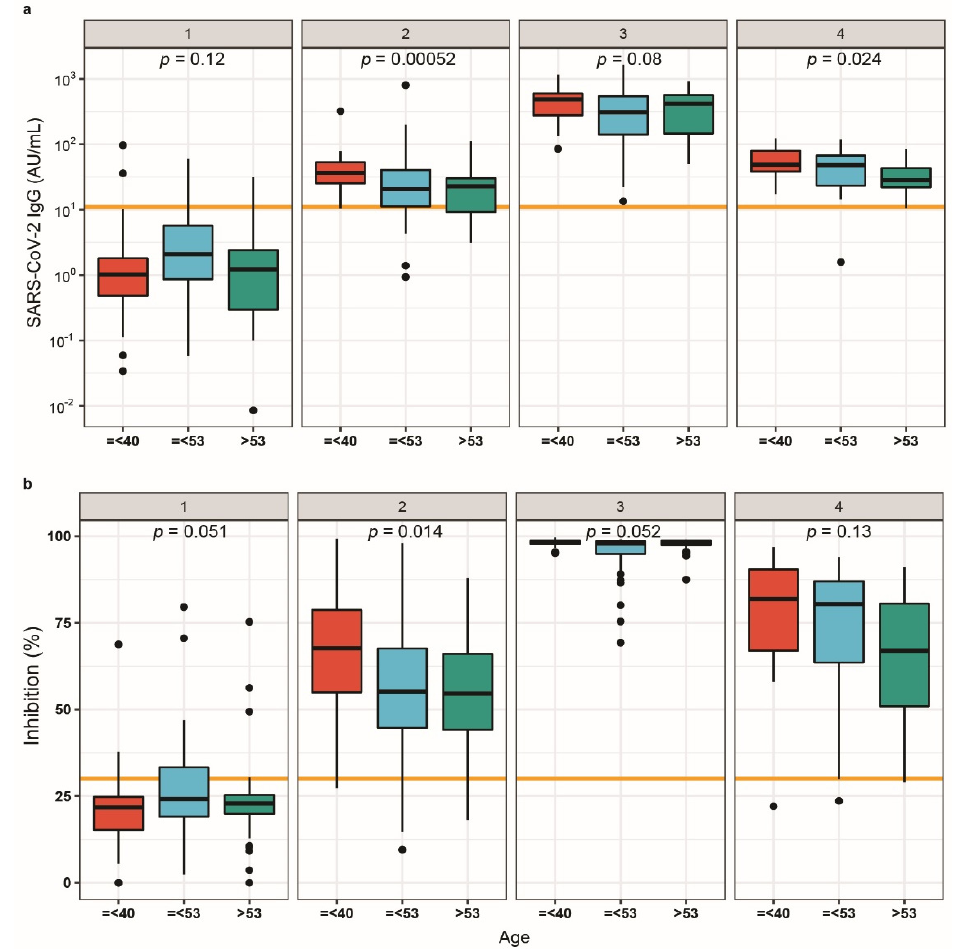
Figure 2. Antibody dynamics according to age groups. ( a ) SARS-CoV-2 IgG titres were evaluated according to age tertiles. Antibody response was inversely associated with age at the second and last time point. ( b ) A similar trend was observed with regard to neutralising antibodies, although significance was lost at the last sampling time point. Two-sided Kruskal-Wallis test was used to compare the groups.